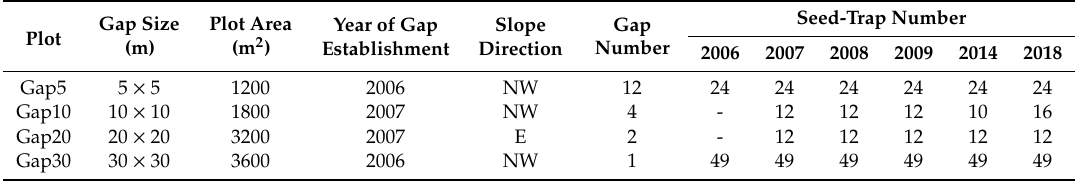
Table 1. Description of gap-mosaic arrangements in the Japanese cypress plantation and number of seed traps.